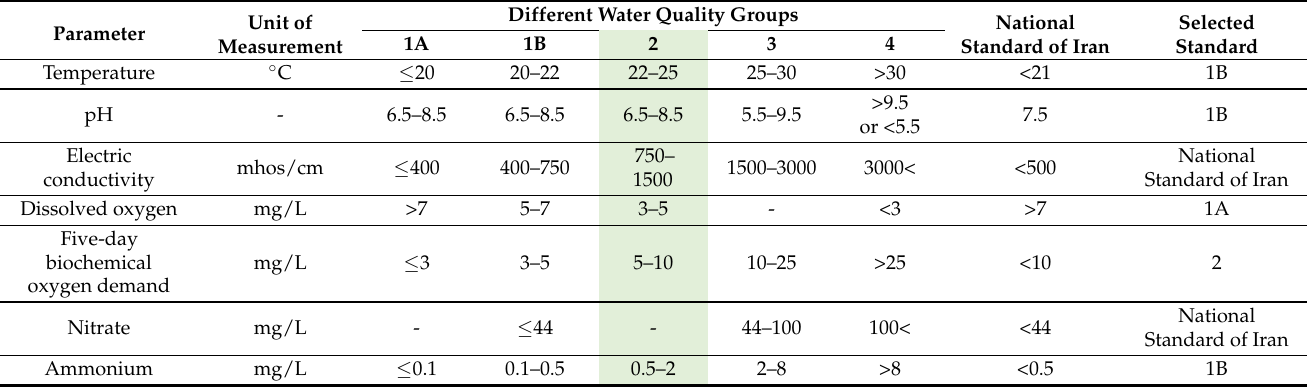
Table 6. Different river water quality standards (after